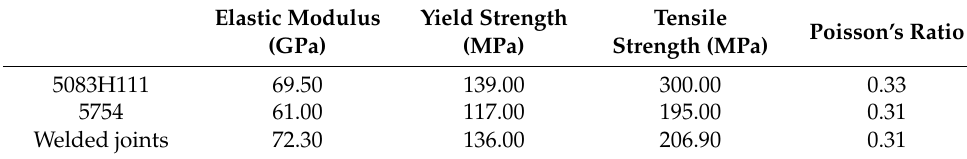
Table 2. Mechanical properties of two aluminum alloys and its welded joints.